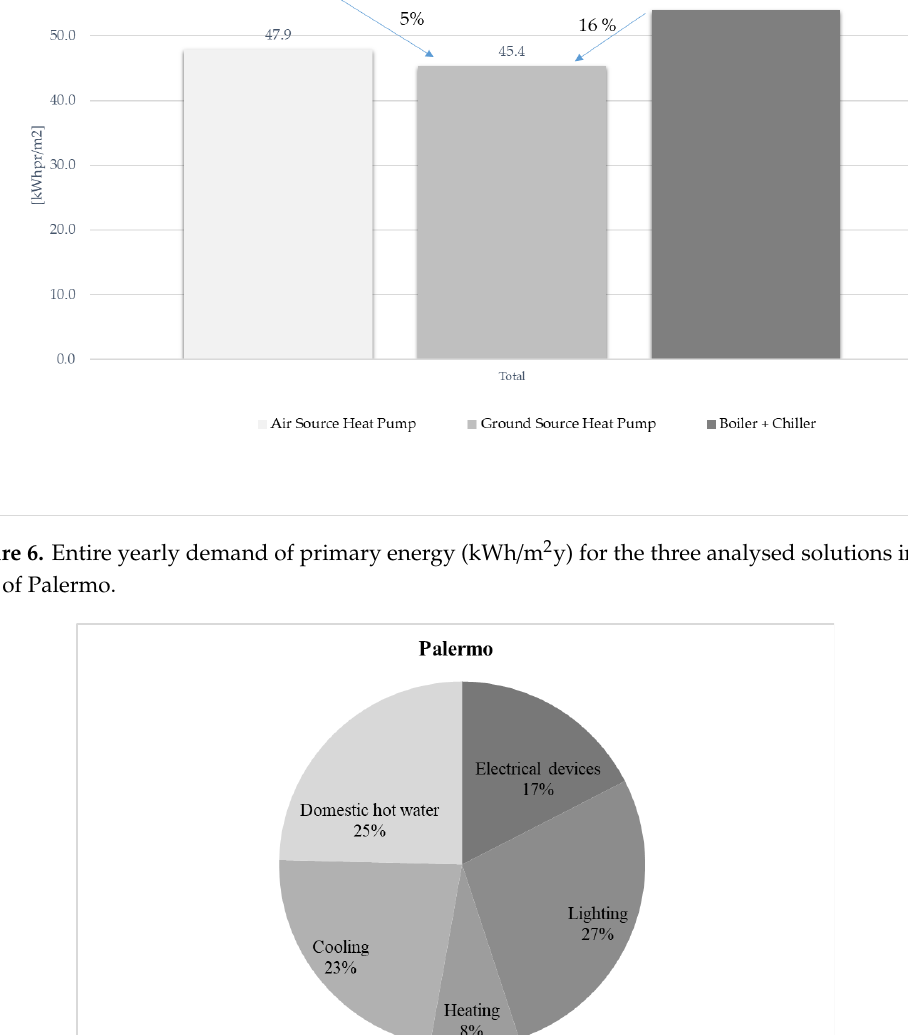
Figure 7. Pie chart relative to the energy requirements in the case of the GSHP for Palermo.